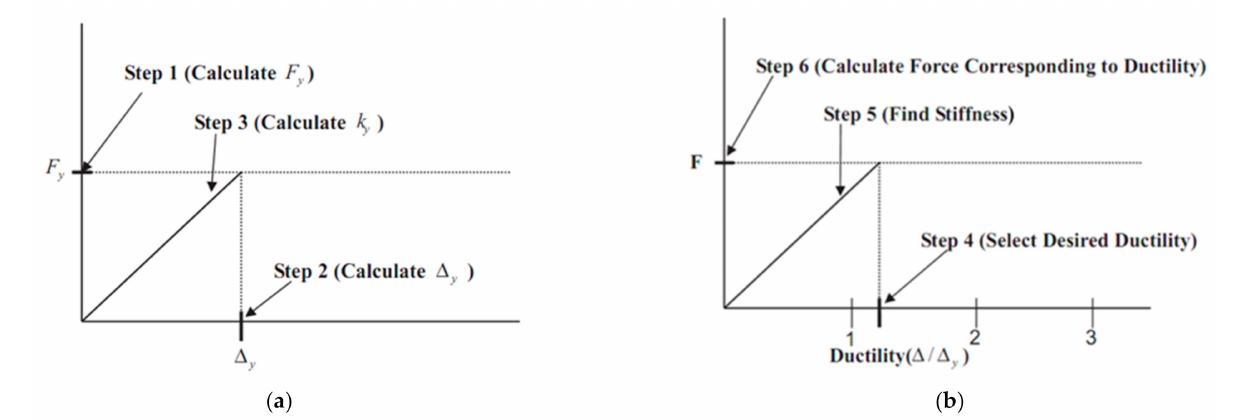
Figure 2. Estimation of post-yield deflection based on stiffness degradation [28]: ( a ) stiffness at the yield limit state, ( b ) stiffness degradation.